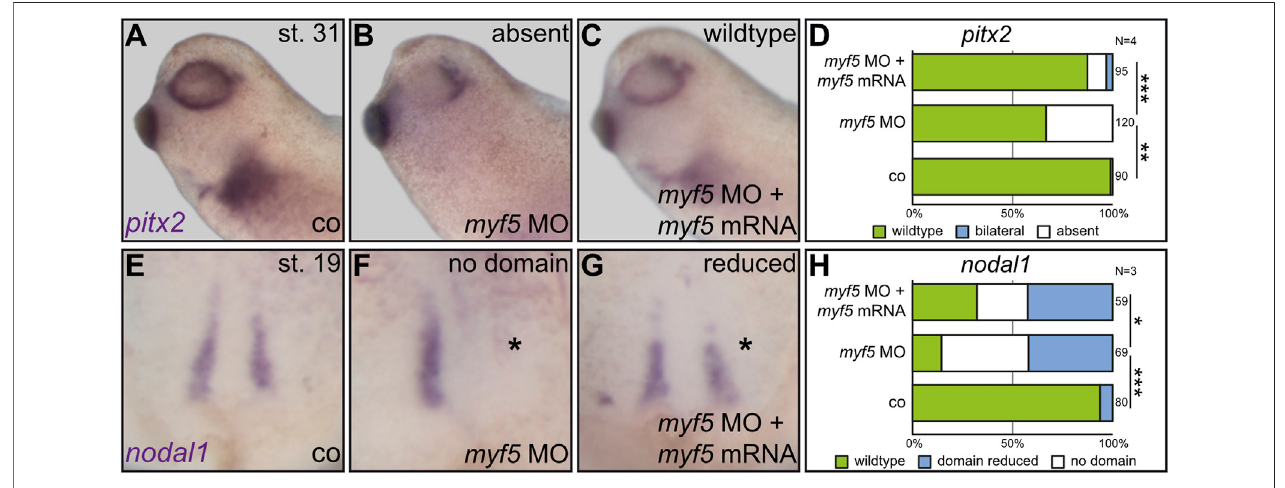
FIGURE 3 | The myogenic transcription factor Myf5 is required for LR asymmetry. In order to connect paraxial patterning to LR development, a myf5 knockdown was conducted in the left sLRO lineage and assayed for pitx2 asymmetry at tadpole (A – D) or nodal1 at neurula stages (E – H) . In contrast to controls [co; (A) ], myf5 morphantslostleft pitx2 expression (B) ,whichwasregainedbytheintroductionof myf5 rescuemRNA (C) .Statisticalanalysisdemonstratesthespeci fi cityofresults (D) . At late neurula, nodal1 expression was lost or reduced by myf5 knockdown (F) which was partially rescued by co-injecting a myf5 rescue mRNA (G) . Statistical analysis is depicted in (H) . Asterisks mark injected sides. Numbers in (D,H) represent analyzed specimens. N represents the number of independent experiments. Statistical analyses were done with one-sided Pearson ’ s chi-square test. * signi fi cant p < 0.05; ** highly signi fi cant p < 0.01; *** very highly signi fi cant p <